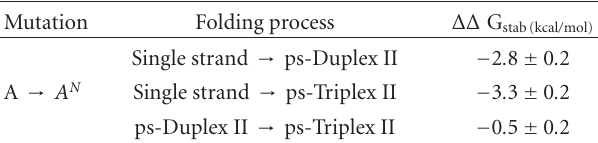
Table 6: Free energy di ff erence (in kcal/mol) in di ff erent folding processes associated to A → A N mutation. A negative sign means that the presence of 8-aminoadenine stabilizes the folded form (right species in column